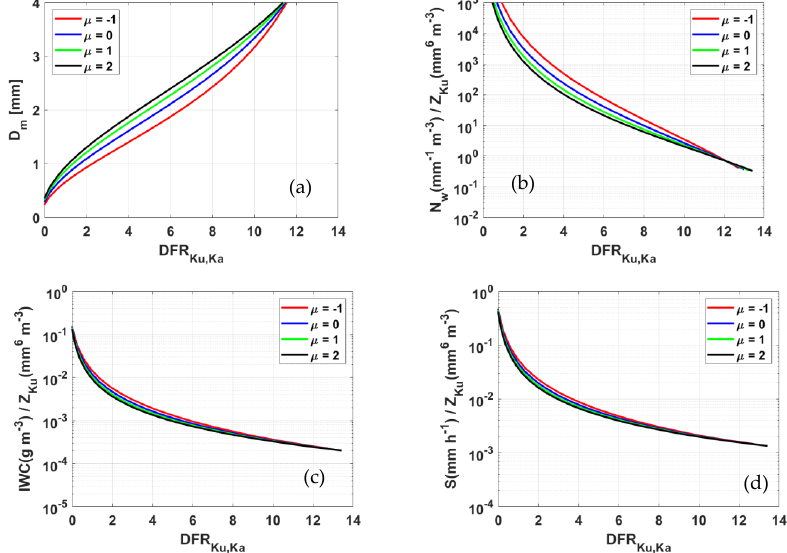
Figure 3. The dual-frequency ratios DFR versus D m ( a ), IWC/Zku ( b ), S/Zku ( c ), and Nw/Zku ( d ) as a function of DFR when the µ values are − 1 (red), 0 (blue), 1 (green), and 2 (black); note that the density of the aggregate is 0.10 g cm − 3 .